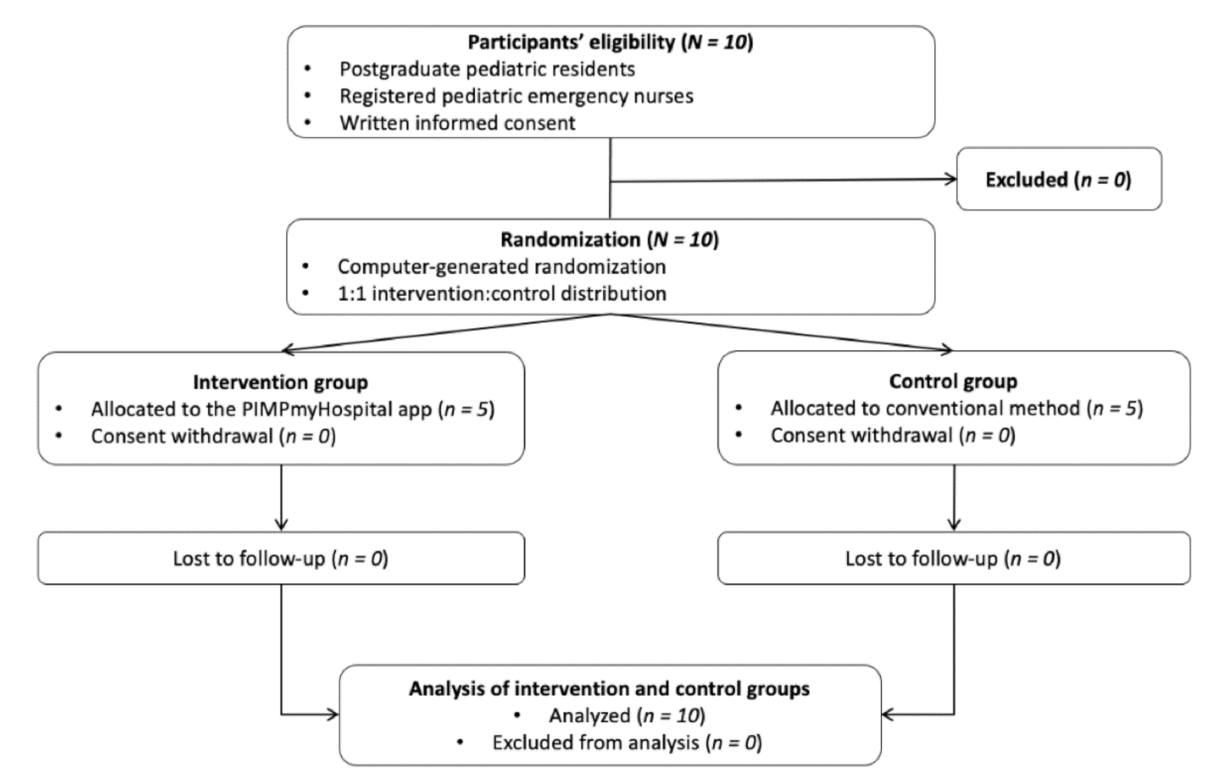
Figure 2. CONSORT